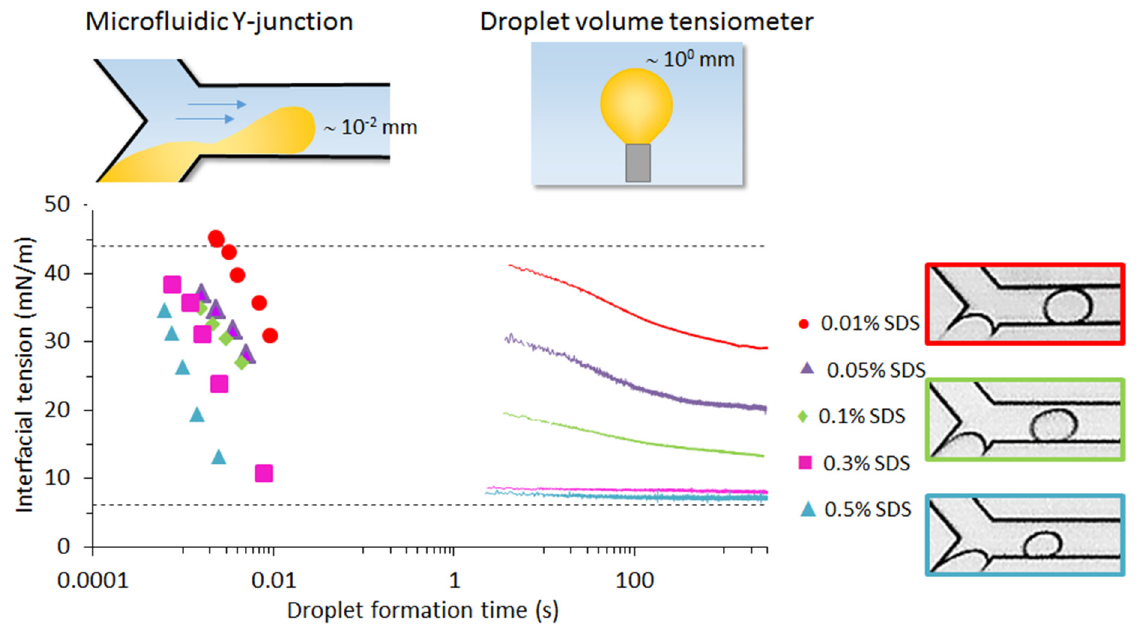
Figure 7. Schematic representation of a microfluidic Y-junction (top left) and of a droplet volume tensiometer (top right). The bottom graph represents the interfacial tension at the hexadecane-water interface with various SDS concentrations in the aqueous phase, as measured with a microfluidic Y-junction (symbols) and with a droplet volume tensiometer (solid lines). The dotted lines represent the equilibrium interfacial tensions without (top) and with surfactant (bottom). Images on the right show droplets made with increasing SDS concentrations. Adapted from [72], with permission from Elsevier.